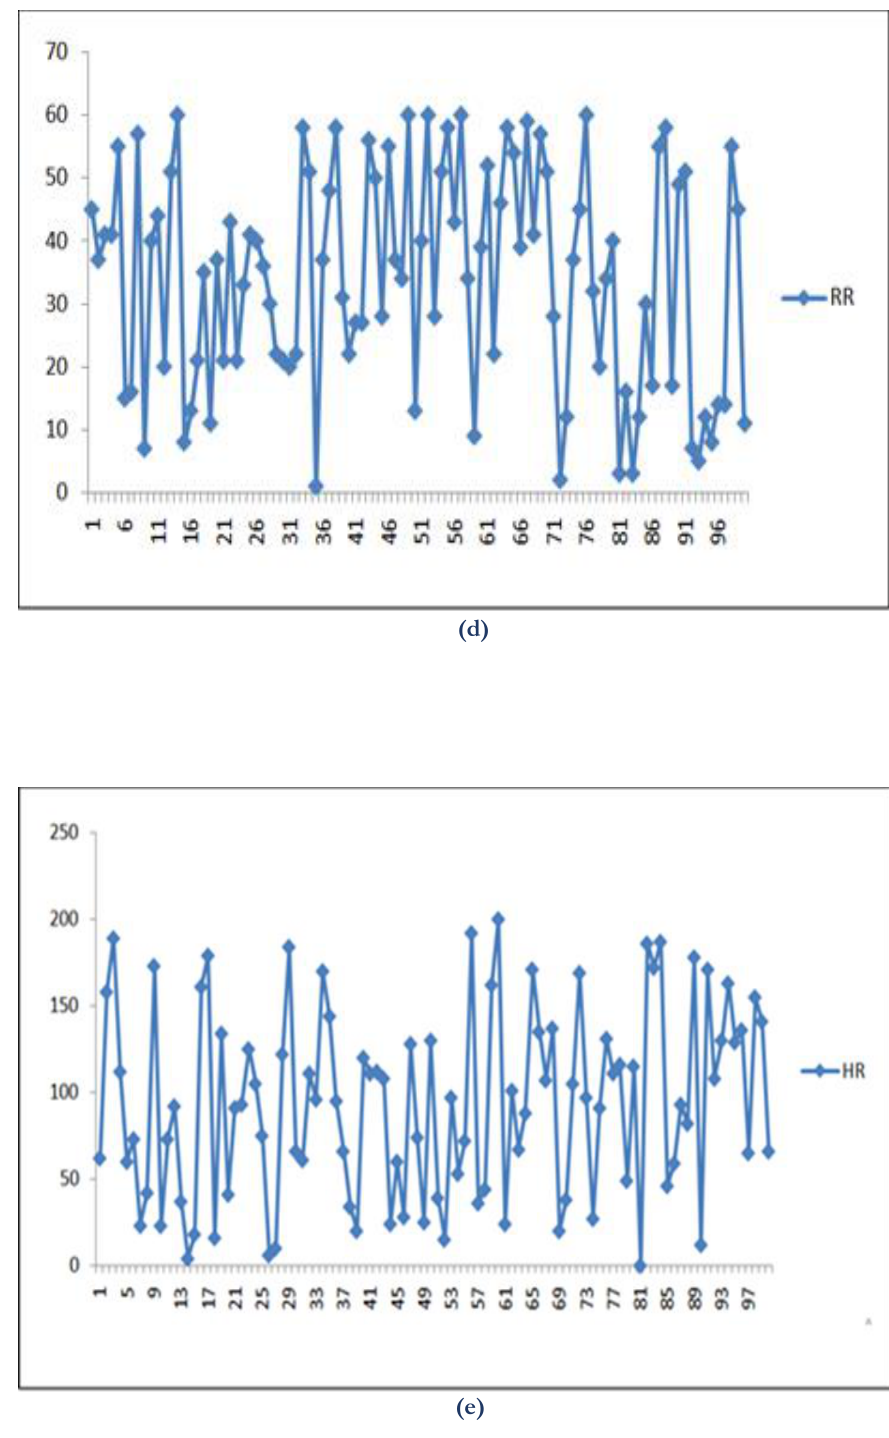
Fig. 6. Plots of the transformed cardiac patients’ health dataset for (a) blood pressure diastolic, (b) blood pressure systolic, (c) temperature, (d) respiratory rate, (e) heart